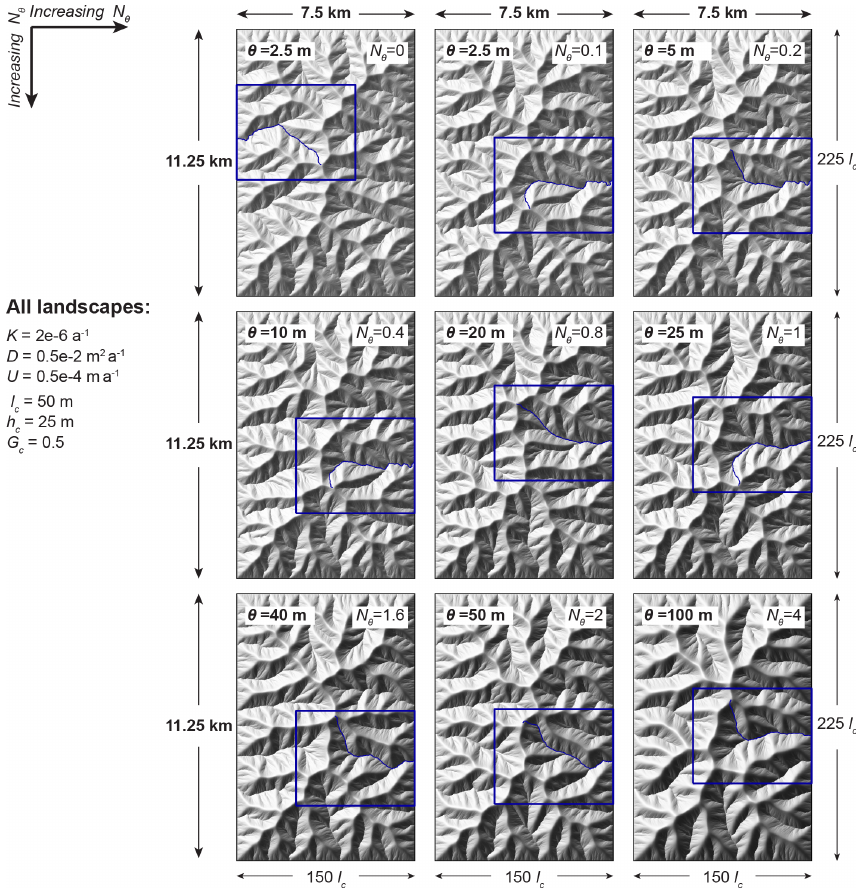
Figure 4. Overview of influence of value of incision-threshold number N θ on morphology of ridges, hillslopes, and valleys. Steady-state shaded relief maps show the nine landscapes of Sect. 3.2, which have equal incision coefficients, diffusion coefficients, and uplift rates (i.e., equal characteristic scales) and unequal incision thresholds, such that N θ values range from 0 to 4 (see parameters in Table 4 and definition of N θ in Eq. 9). The maps are arranged such that N θ increases from left to right and from top to bottom. We interpret these shaded relief maps in the description of Fig. 5, where we show enlarged views of a rectangular region from each map to enhance the visibility of landscape features. Here we show these regions with blue rectangles. Their extents are 5km × 4km (equivalently, 100 l c × 80 l c ) and are chosen such that they contain each landscape’s longest flow path and the corresponding drainage basin. We mark these flow paths with blue lines, and we present profile plots along their course in Figs. 9 and